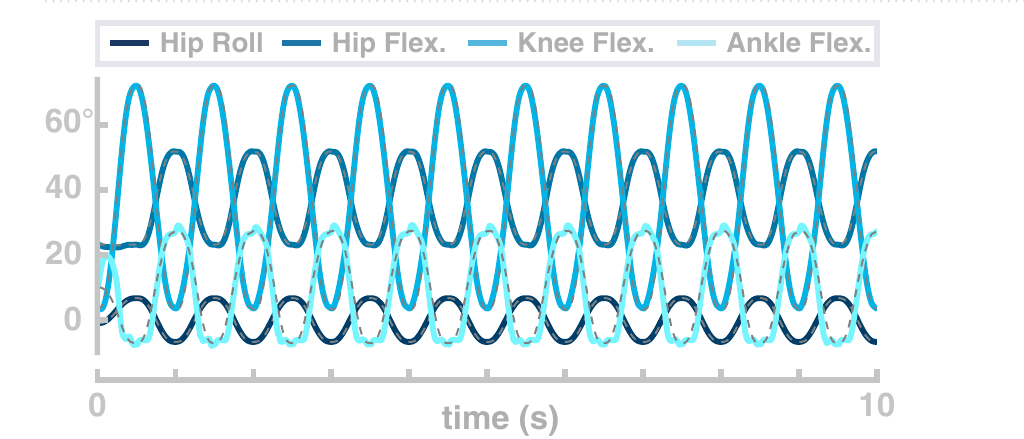
Figure 3. Swing leg ankle paths for a sequence of twelve center-out-return movements with passively stabilized trunk. The same movements are shown in three different views. ( A ) 3D perspective view, ( B ) side view of the sagittal plane and ( C ) top-down view of the horizontal plane. The dashed lines show the planned paths and the blue lines show the realized ankle paths.